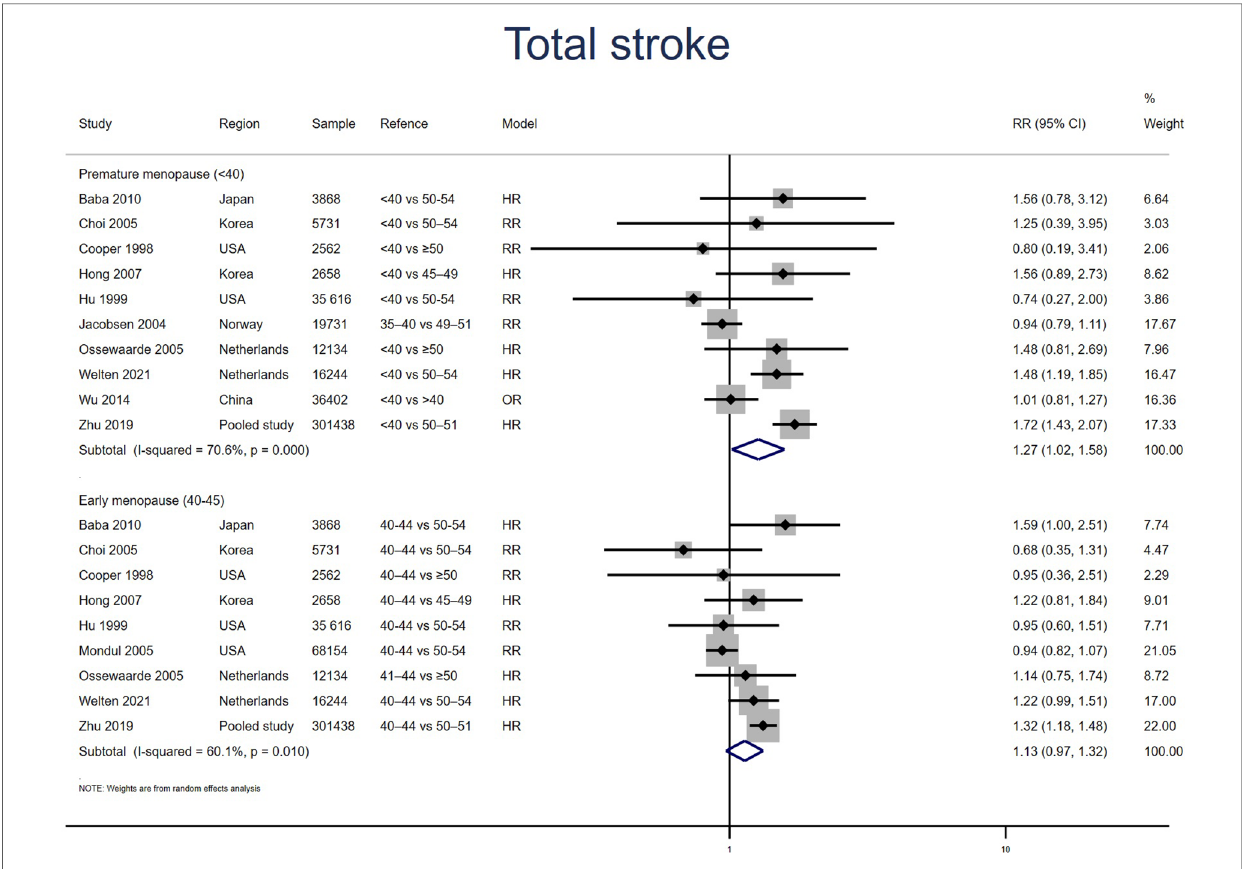
FIGURE 6 Forest plot presents the association between PM or EM and the risk of stroke in cohort